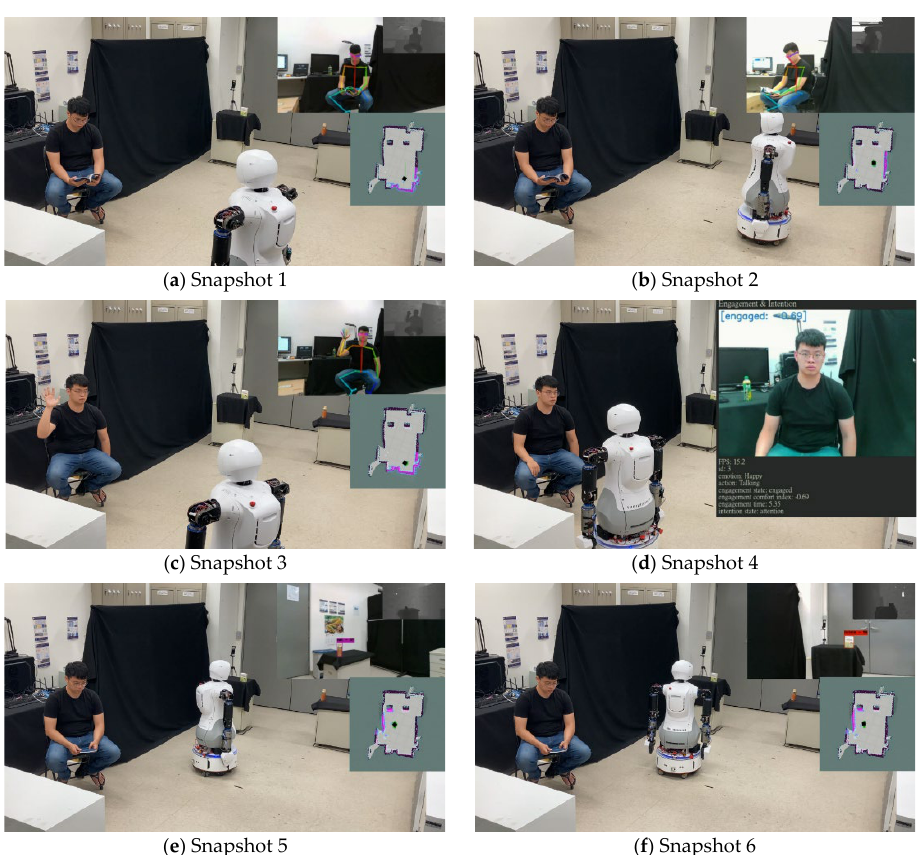
Figure 16. Snapshots from patrol to a conversation, then identifying the object to be tracked. ( a , b ) Patrol. ( c ) Recognition of a trigger gesture for human-robot interaction. ( d ) Deployment of engagement and intention model. ( e , f ) Identification of the object to be tracked.